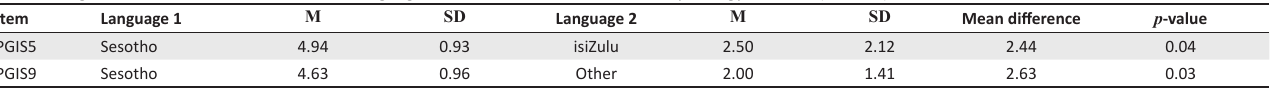
TABLE 6: Significant mean differences between languages in terms of PGIS items for I-O Psychology students ( N = 565).